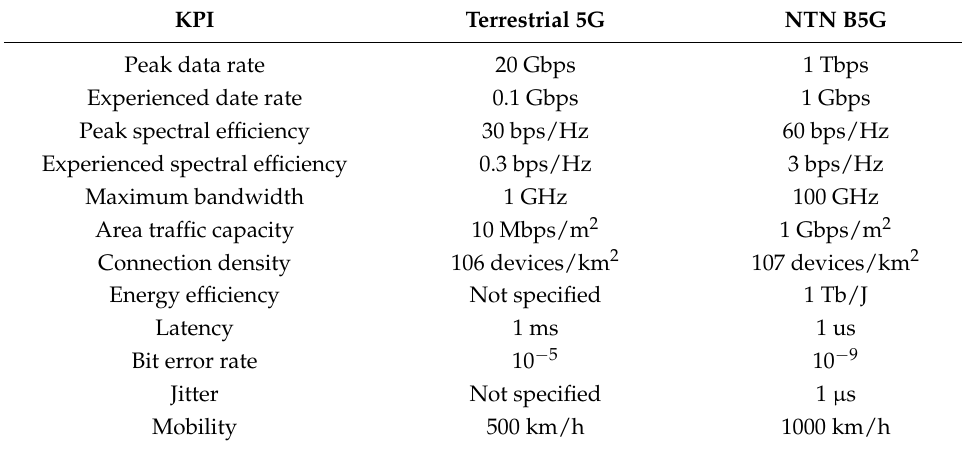
Table 2. Key performance